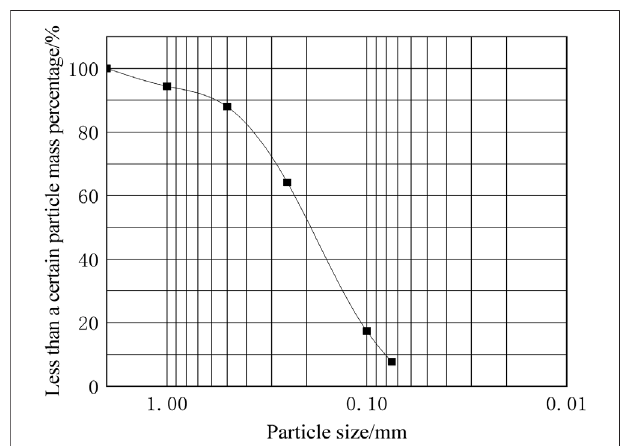
FIGURE 1 | Fly ash particle grading